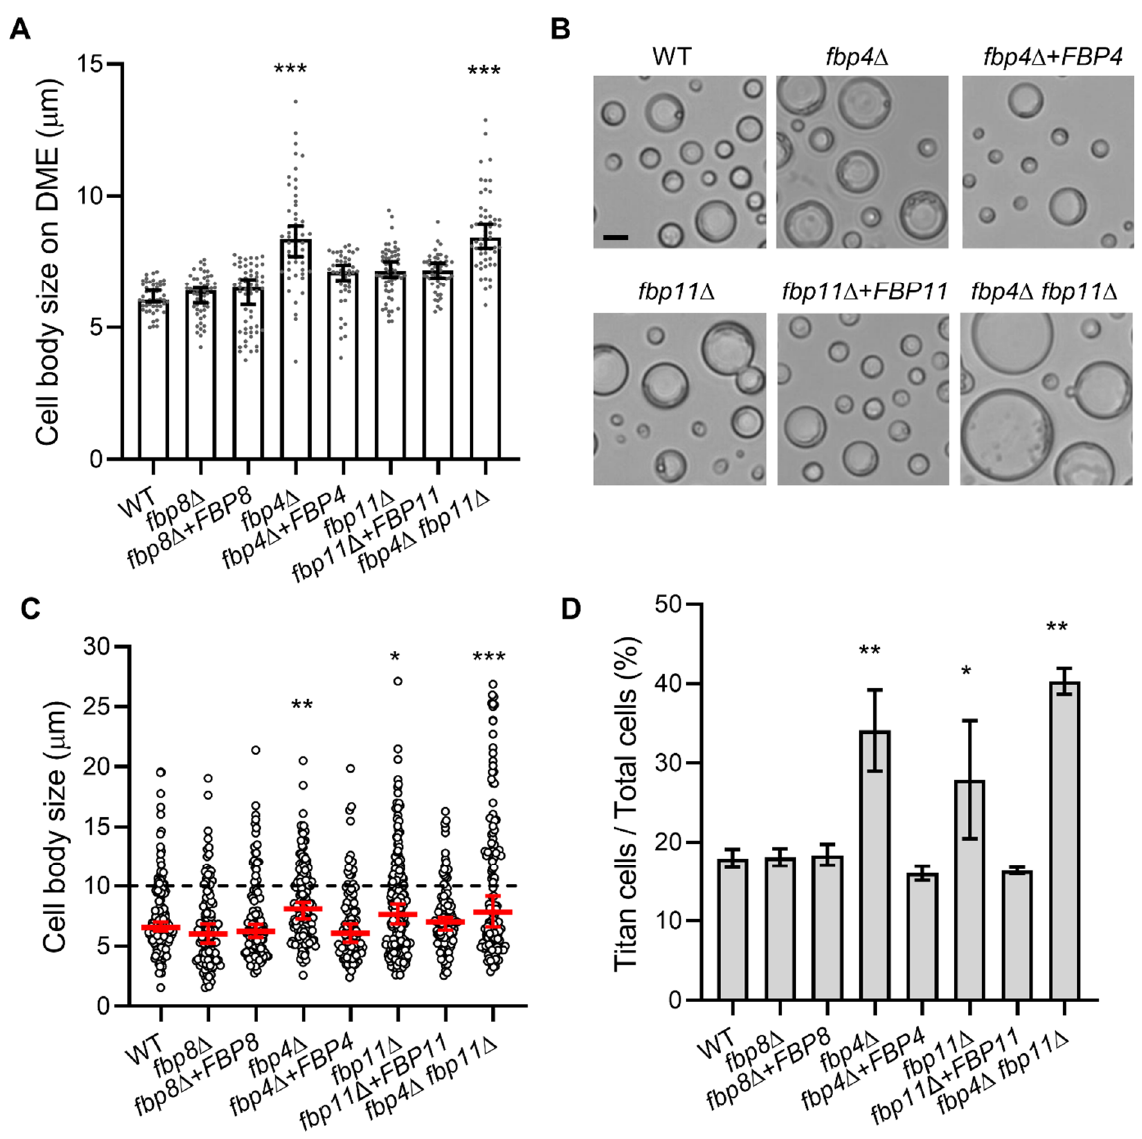
Figure 3. Fbp4 and Fbp11 are required for cell size control. ( A ) Quantitative measurement of cell body size grown on DME medium for 7 days. Error bar indicates the standard deviation of the mean for more than 50 cells. ( B ) Representative images of WT, fbp4 ∆ , fbp4 ∆ + FBP4 , fbp11 ∆ , fbp11 ∆ + FBP11 , and fbp4 ∆ fbp11 ∆ strains under in vitro titan cell inducible condition. Bar, 10 µ m. ( C , D ) Quantitative measurement of cell size ( C ) and titan cell percentage ( D ) of strains cultured under in vitro titan cell inducing conditions. Error bar indicates the standard deviation of the mean for more than 100 cells. Statistical analysis for all measurements in this figure was performed with